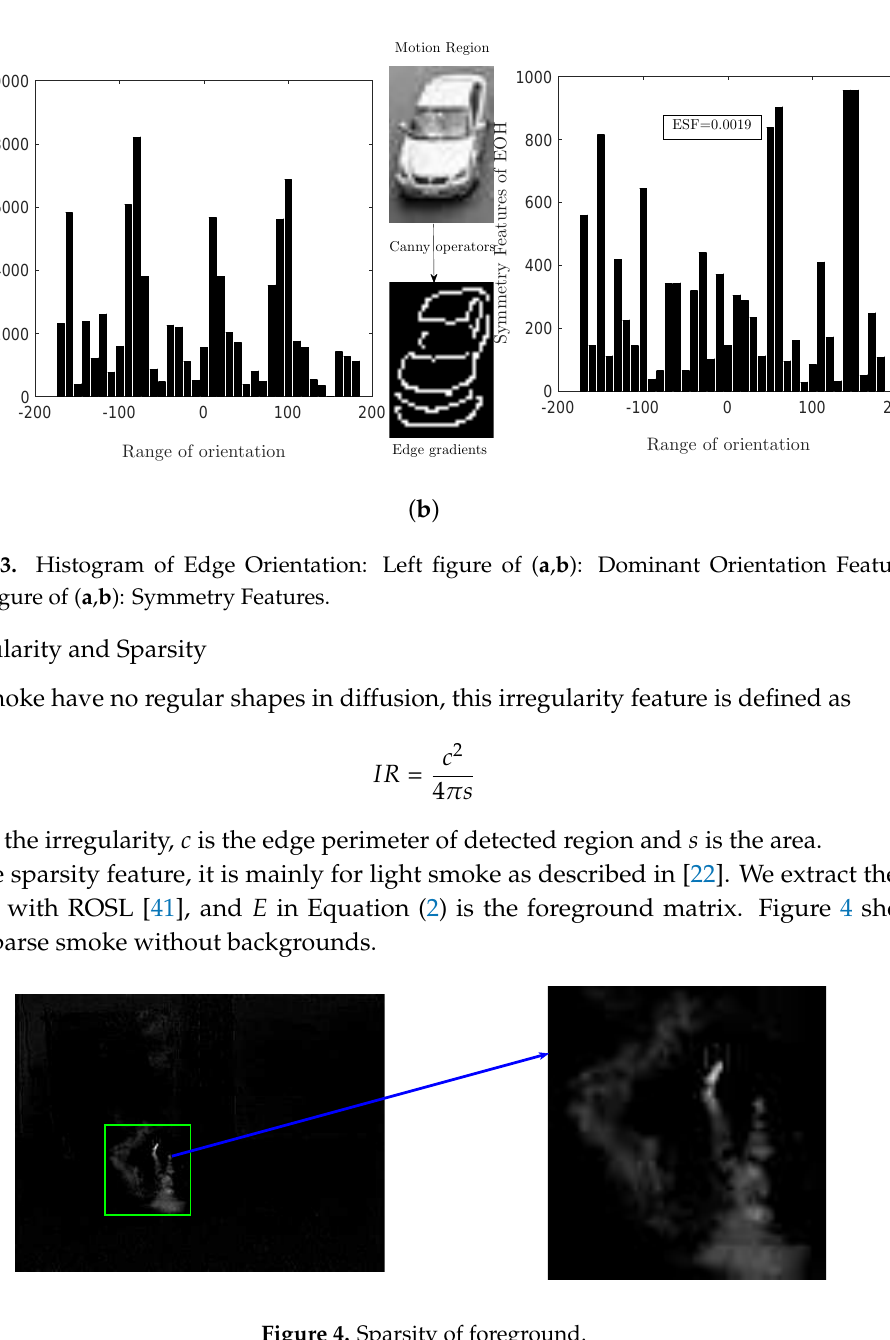
Figure 4. Sparsity of